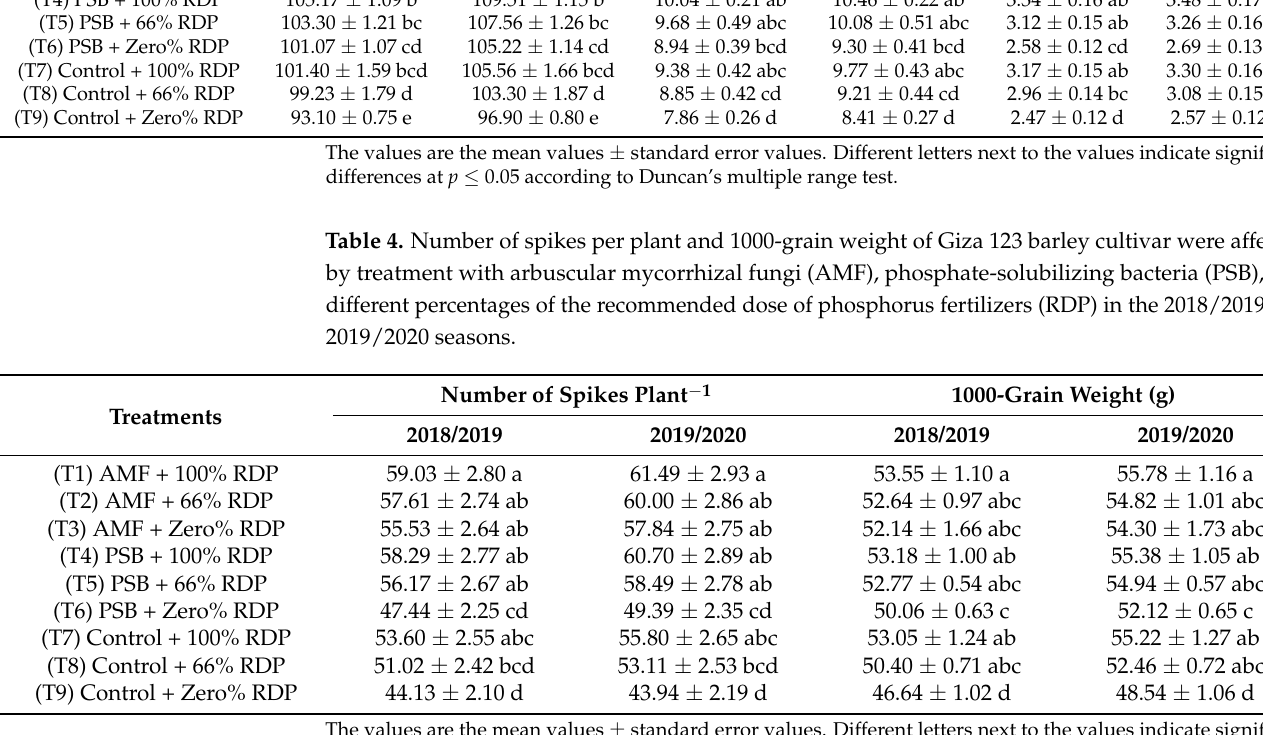
The values are the mean values ± standard error values. Different letters next to the values indicate significant differences at p ≤ 0.05 according to Duncan’s multiple range test. Table 5. Biological yield and harvest index of barley Giza 123 cultivar were influenced by the treatment of arbuscular mycorrhizal fungi (AMF), phosphate-solubilizing bacteria (PSB), and dif- ferent percentages of the recommended dose of phosphorus fertilizers (RDP) in the 2018/2019